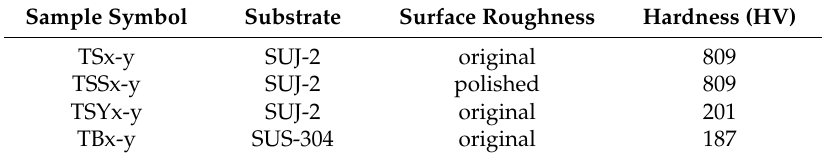
Table 3. Relevant sample symbols and treatment condition of the balls in the present work.